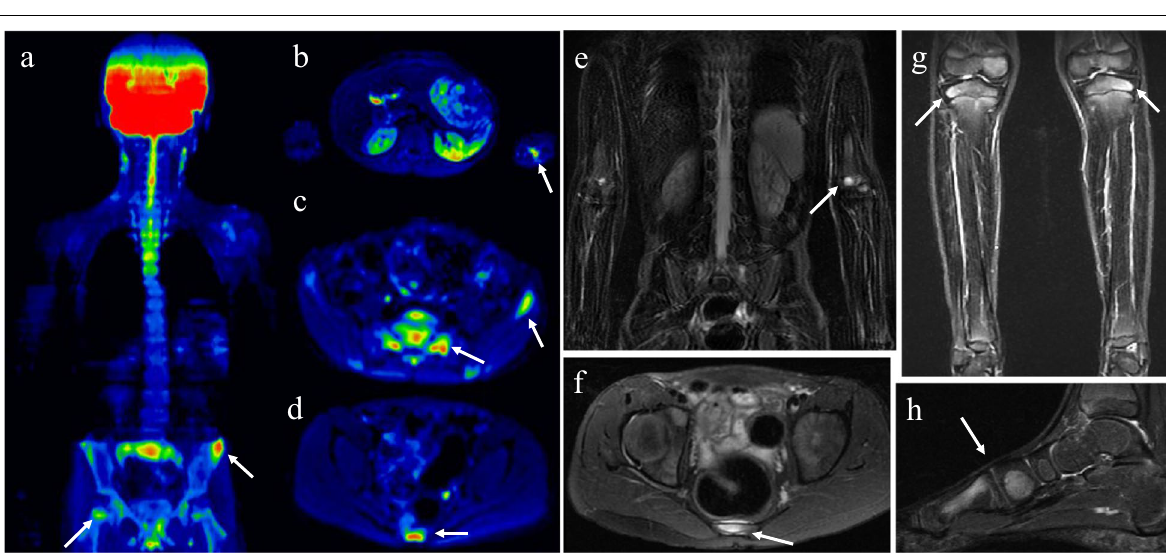
Fig. 10 6-year-old male child with history of pain in his right hip and alteration of his gait for 6 months, with positive inflammatory tests, without trauma or fever and an investigation of hip synovitis. Initial MRI of the pelvis showed periphyseal lesions with symmetrical and bilateral distribution, in addition to involvement of the lower lumbar spine (not shown), raising the possibility of CNO. The WB-MRI study was suggested and performed 24 h after the first examination ( a – h ). DWI sequences ( a – d ) showing lesions already identified in the previous pelvic examination and detection of a new asymptomatic lesion in the capitellum ( b ), also demonstrated by the morphological sequence STIR ( e ). STIR sequences of the pelvis ( f ), legs ( g ) and left foot ( h ), with peripheral edema in the vertebrae, lateral tibial plateaus and in the medial cuneiform region and in the first metatarsal region, respectively. In WB-MRI, some lesions were detected in asymptomatic sites, demonstrating the multifocality and characteristic distribution of the disease and confirming its